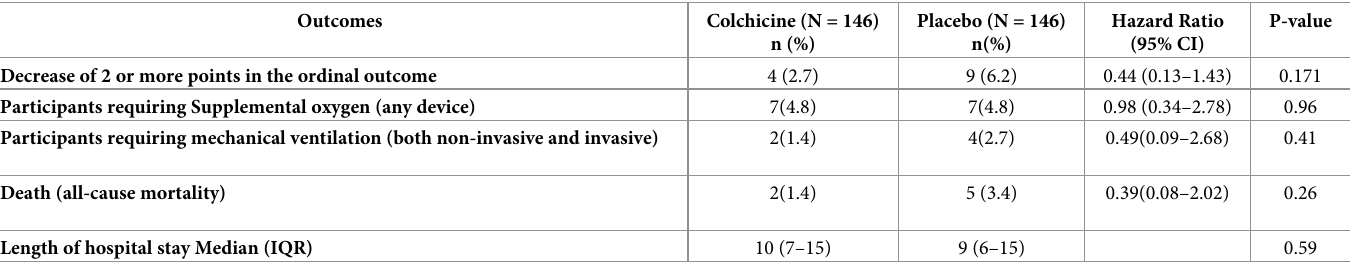
Table 2. Clinical outcomes of patients administered colchicine compared with those administered placebo on day 14 of follow-up.